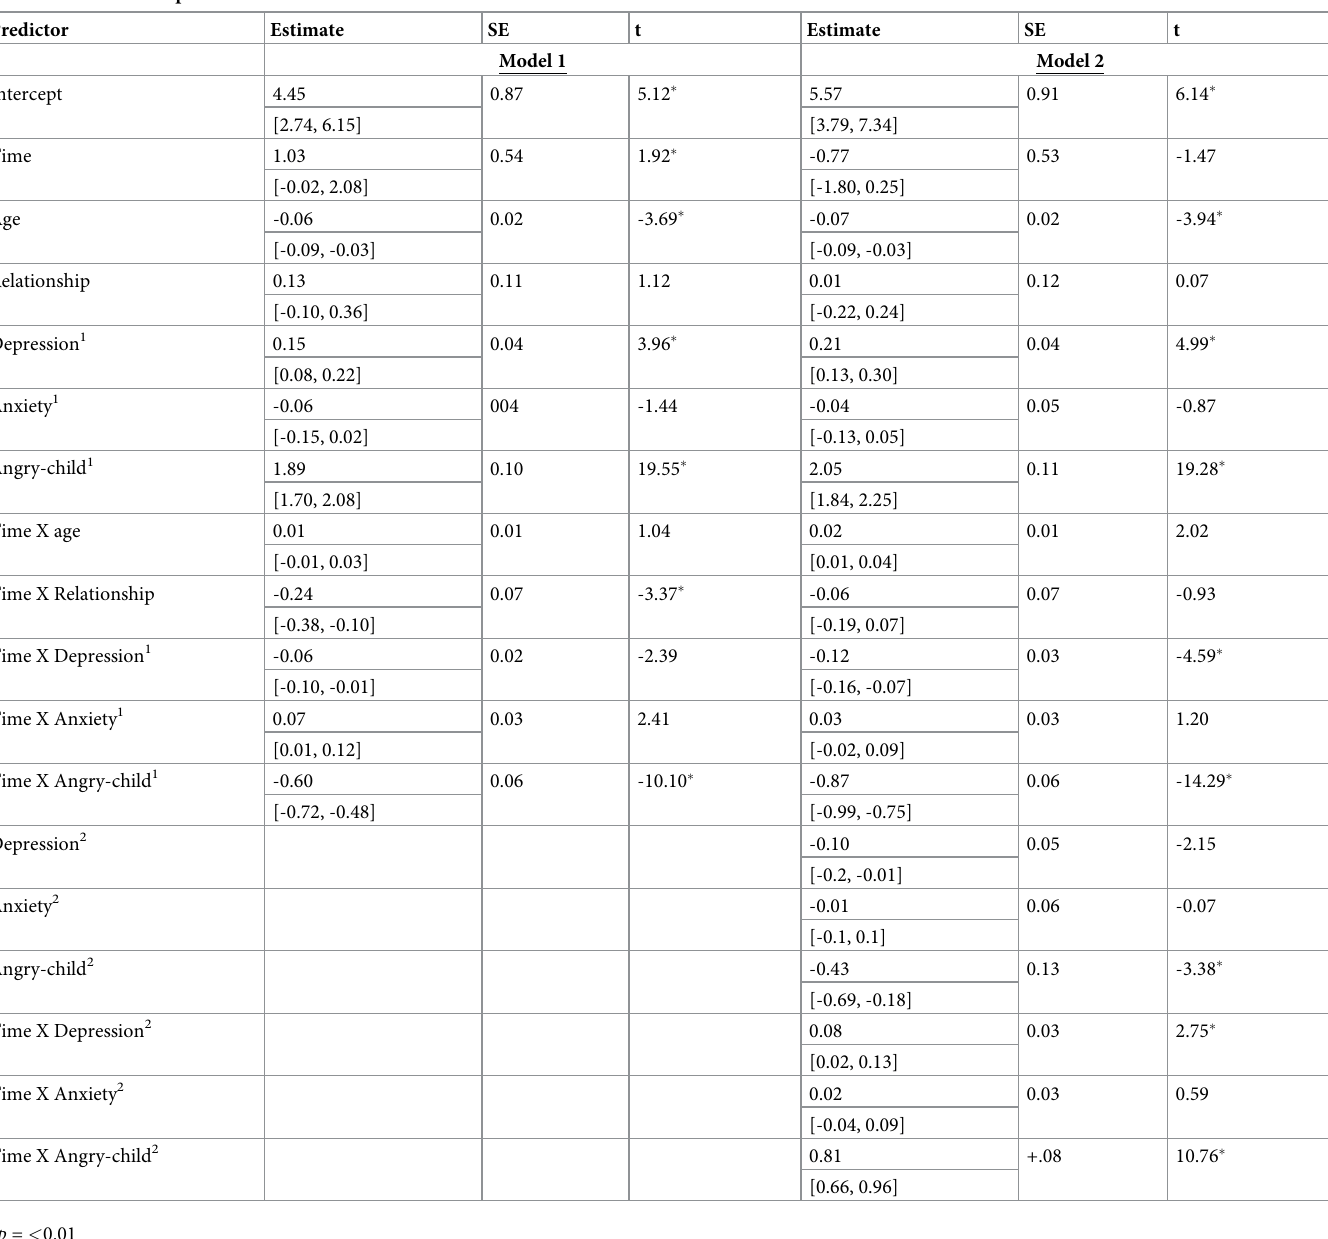
Table 5. Predictors of parental